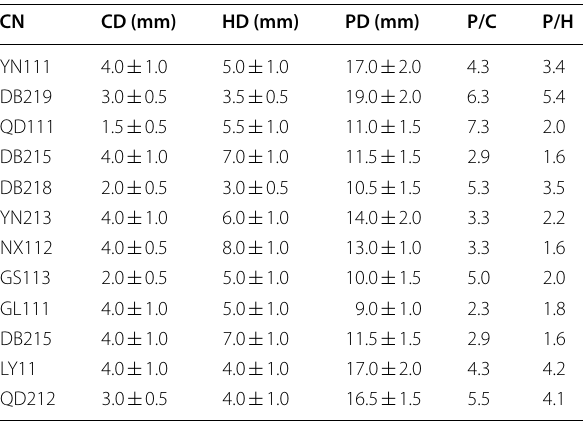
Table 1 The diameter of hydrolysis and precipitation rings on the solid casein medium